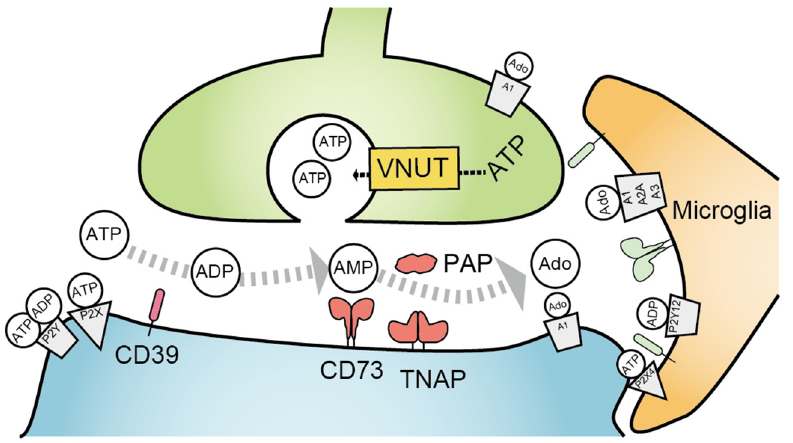
Figure 5. The process of adenosine triphosphate (ATP) release and metabolism at extracellular space.